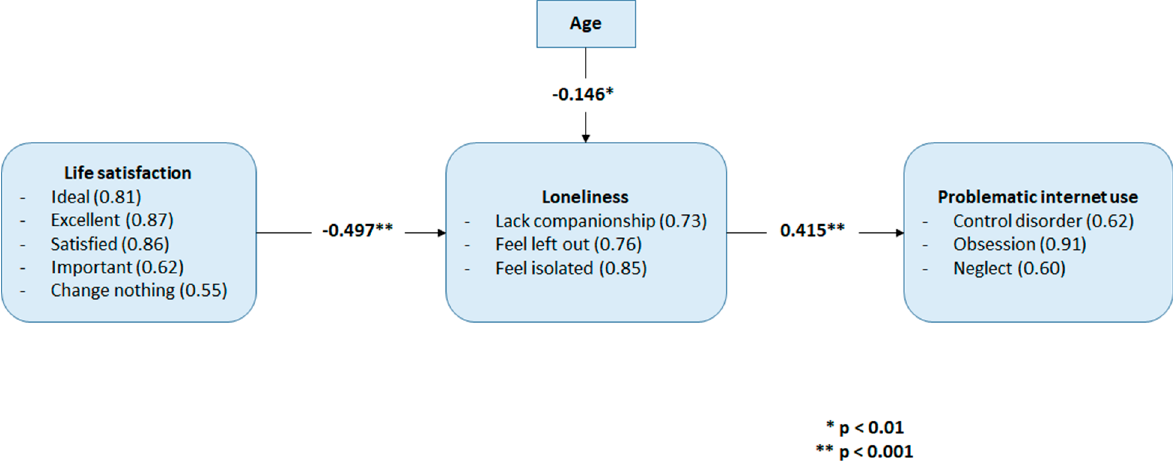
Figure 2. The estimated operational model.